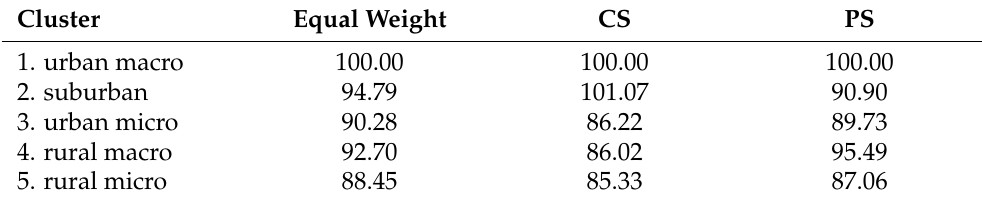
Table 8. Composite indicator obtained normalizing with respect to reference cluster 1 = 100.00.